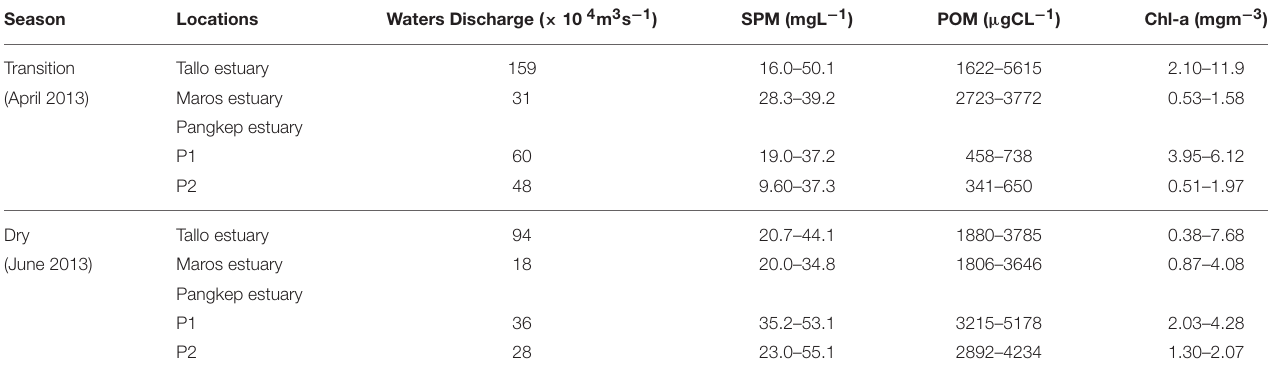
TABLE 1 | Comparison of river water discharges, SPM ( Suspended Particulate Matter ), POM ( Particulate Organic Matter ) and chlorophyll-a in transition season and dry season on the west coast of South Sulawesi, Indonesia.